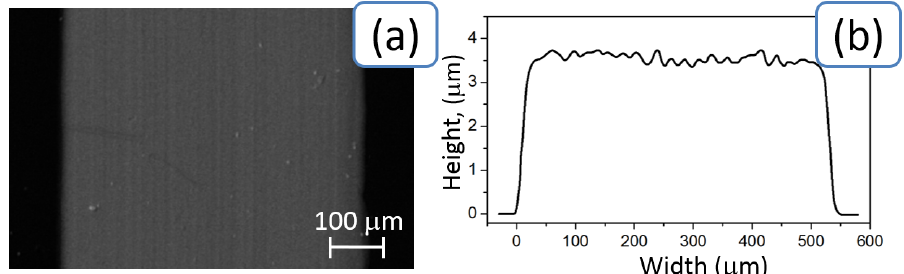
Figure 2. SEM image of the printed Ag line ( a ) and the line profile extracted from atomic force microscopy (AFM) measurement ( b ). The height curve of the conductor over the entire width was average 4 µm.